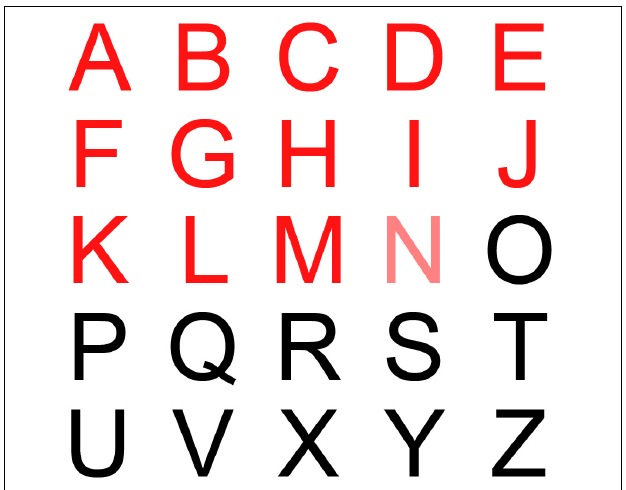
FIGURE 2 | Tablet display of alphabets in the tMTT in front of the participants while they exercised on a treadmill.